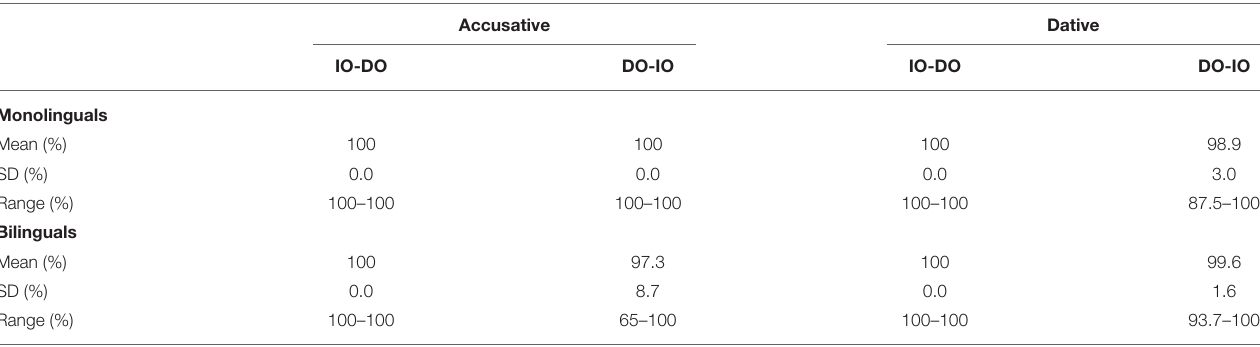
TABLE 4 | Performance of ditransitives in monolinguals and bilinguals in the production task.